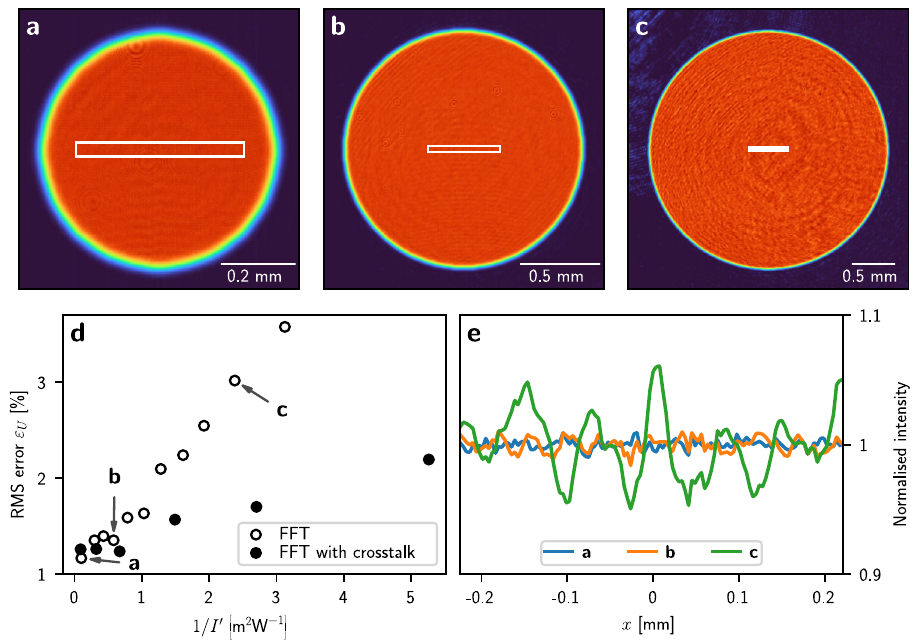
Figure 3. Effect of pattern size and pixel crosstalk on the RMS error. ( a )–( c ) Disc-shaped potentials (diameters D = 0.6mm , D = 1.5mm and D = 2.8mm ), generated using camera feedback without the pixel crosstalk model, and normalised by the average intensity in the flat part of the disc. ( d ) RMS error of disc-shaped light potentials of different diameters with and without the pixel crosstalk model. ( e ) Horizontal profiles of the light potentials, averaged over 10 rows within the white rectangles in ( a )–( c